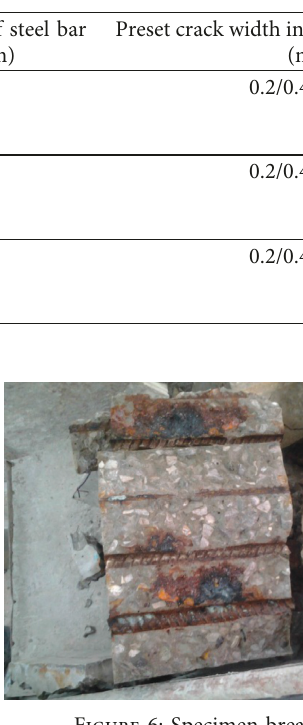
Table 2: The levels of test parameters.